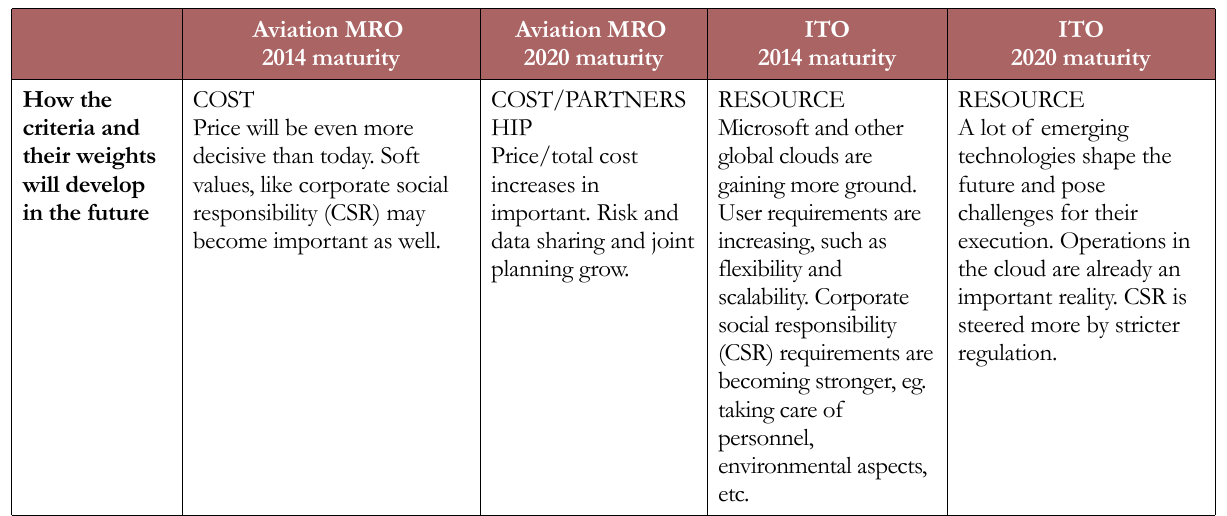
Table 3. Summary of the interview findings from the MRO and ITO